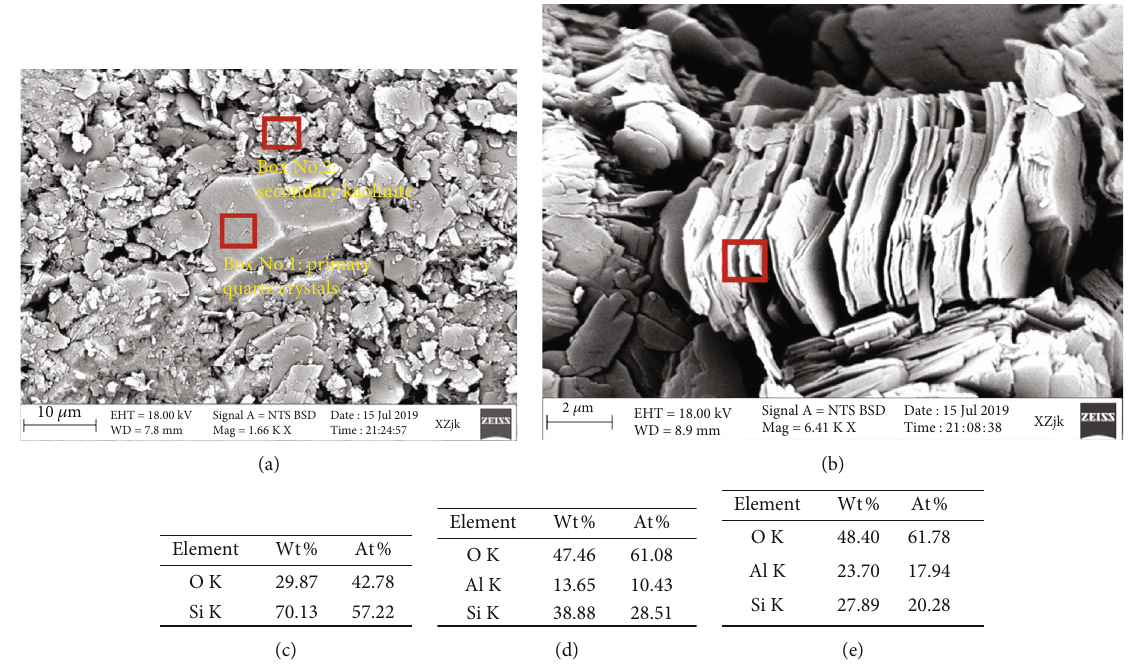
Figure 6: Secondary minerals adhering to the primary minerals at the fracture surface in the coarse-grained sandrock specimen. (a) Secondary kaolinite adhering to the quartz crystals after the experiment. (b) Primary kaolinite. (c) EDS analysis in the No. 1 box of Figure 6(a). (d) EDS analysis in the No. 2 box of Figure 6(a). (e) EDS analysis in the box of Figure